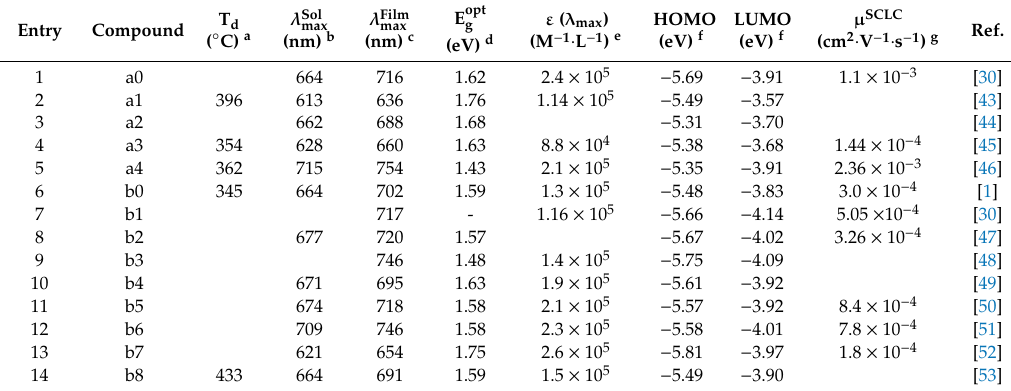
Table 1. Optical and electrochemical properties of acceptors a0–a4 and b0–b8.